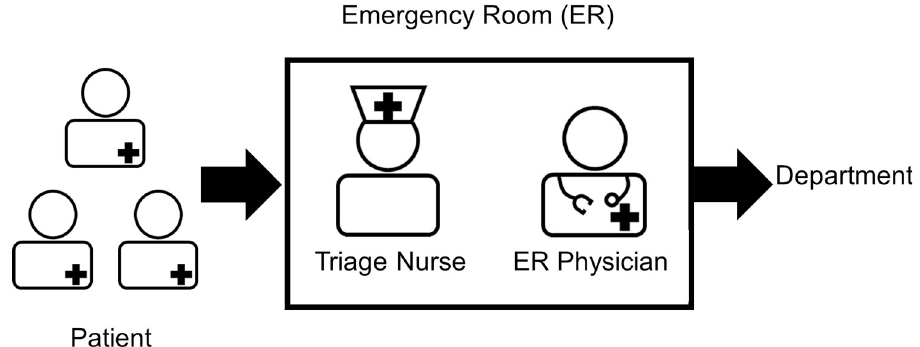
Fig 3. Overview of the emergency room system in the United